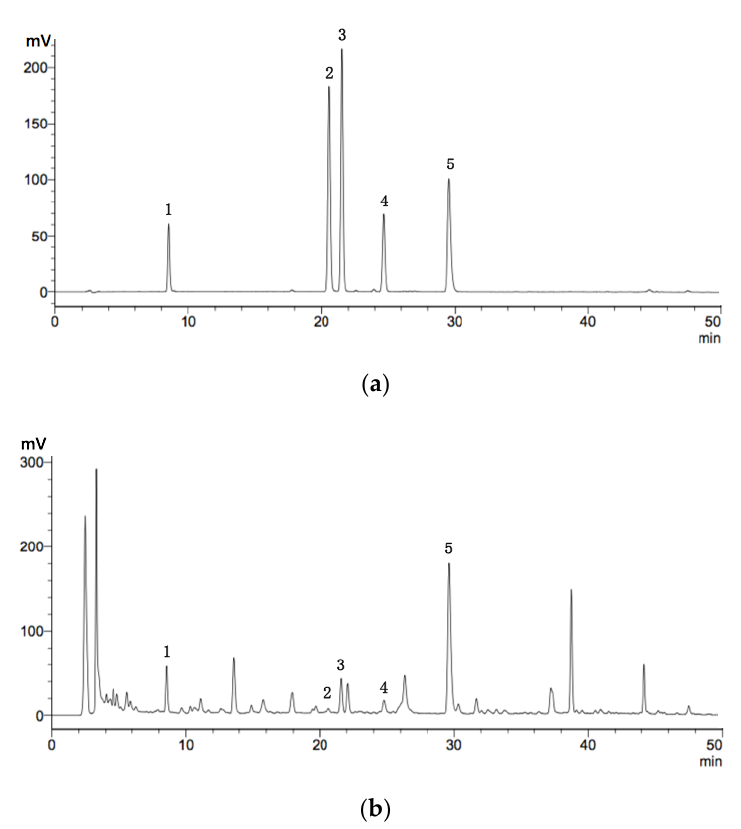
Figure 5. HPLC chromatogram of mixed reference ( a ) and extraction samples ( b ). 1: trifolirhizin; 2: formononetin; 3: isoxanthohumol; 4: maackiain; 5: kurarinone.